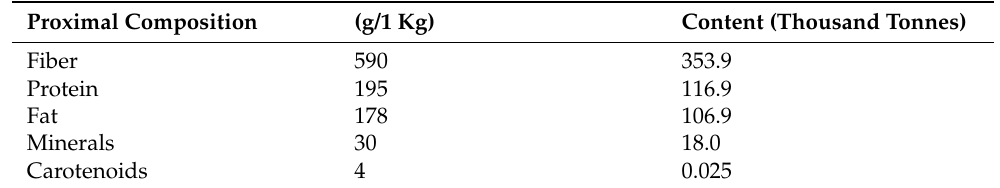
Table 7. Amount of valuable ingredients can be recovered in 600 thousand tomato processing